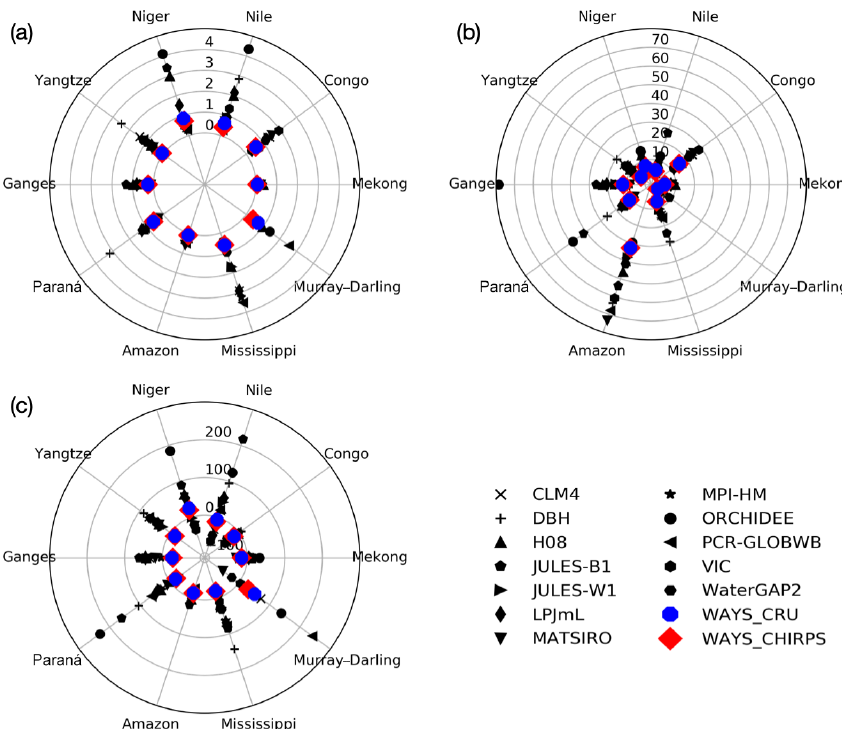
Figure 4. The catchment clockwise pole plot according to different metrics: (a) 1-NSE, (b) RMSE, and (c) PBIAS. Colored markers indicate the score for the WAYS model with two different simulations, and black markers represent the score for ISIMIP2a models. For all the metrics, the value of 0 is the